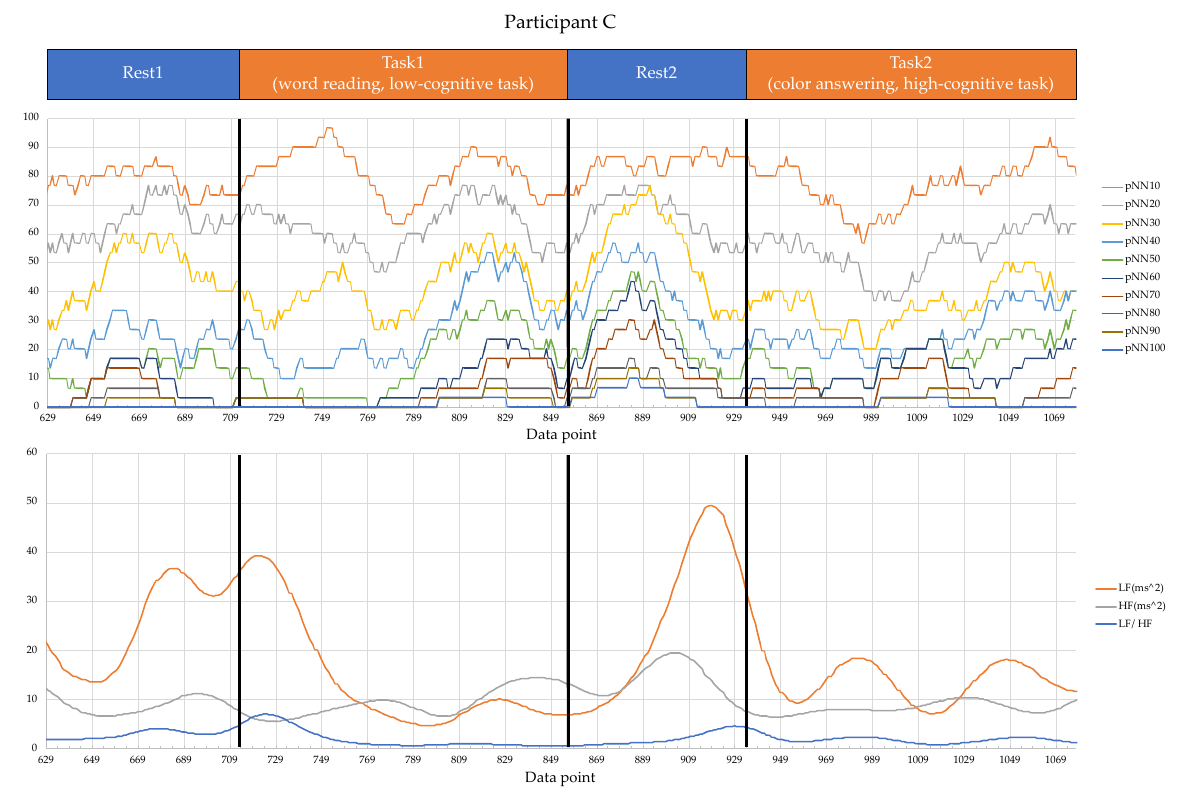
Figure 5. Raw waveforms used to calculate the HRV indexes of Participant C.